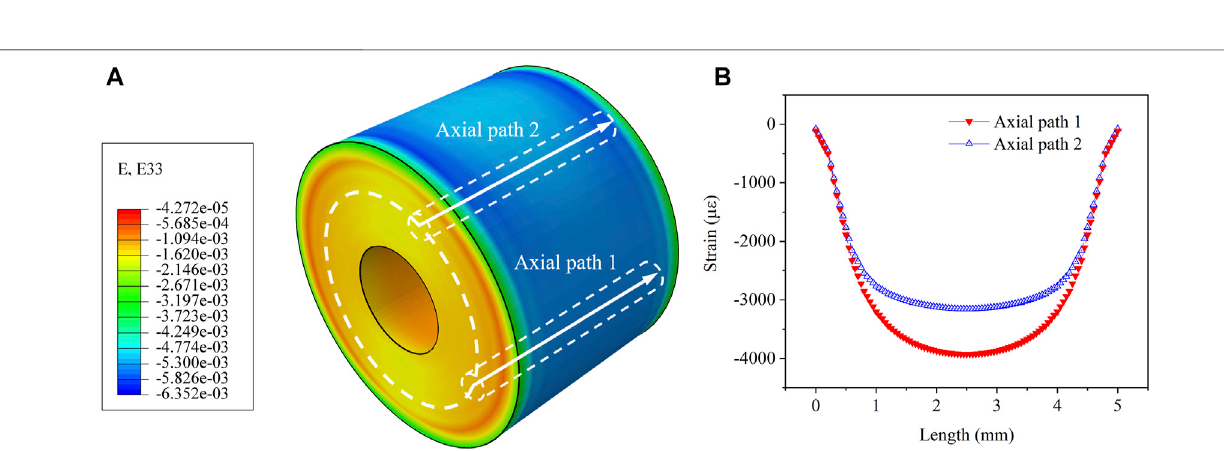
Frontiers in Energy Research |